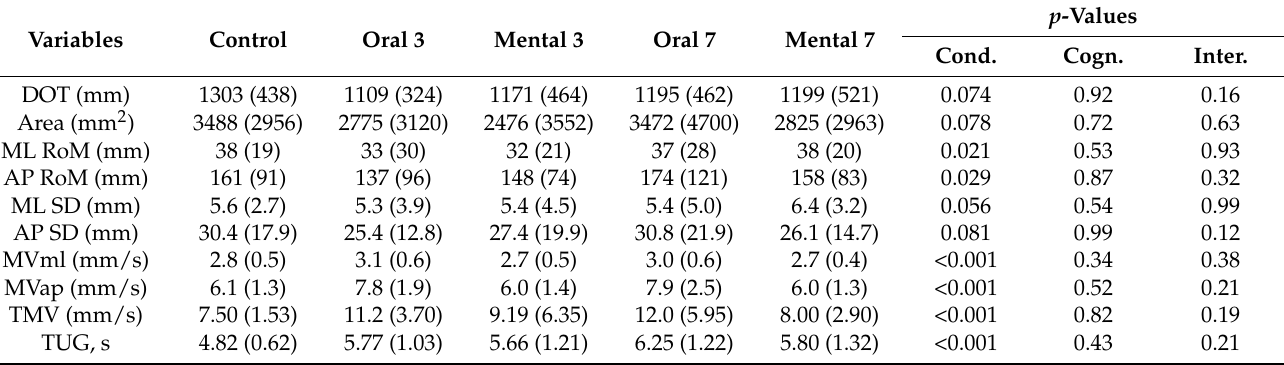
Table 2. Mean (std) results for the studied parameters under the five different conditions. p -values are the results of the ANOVA.